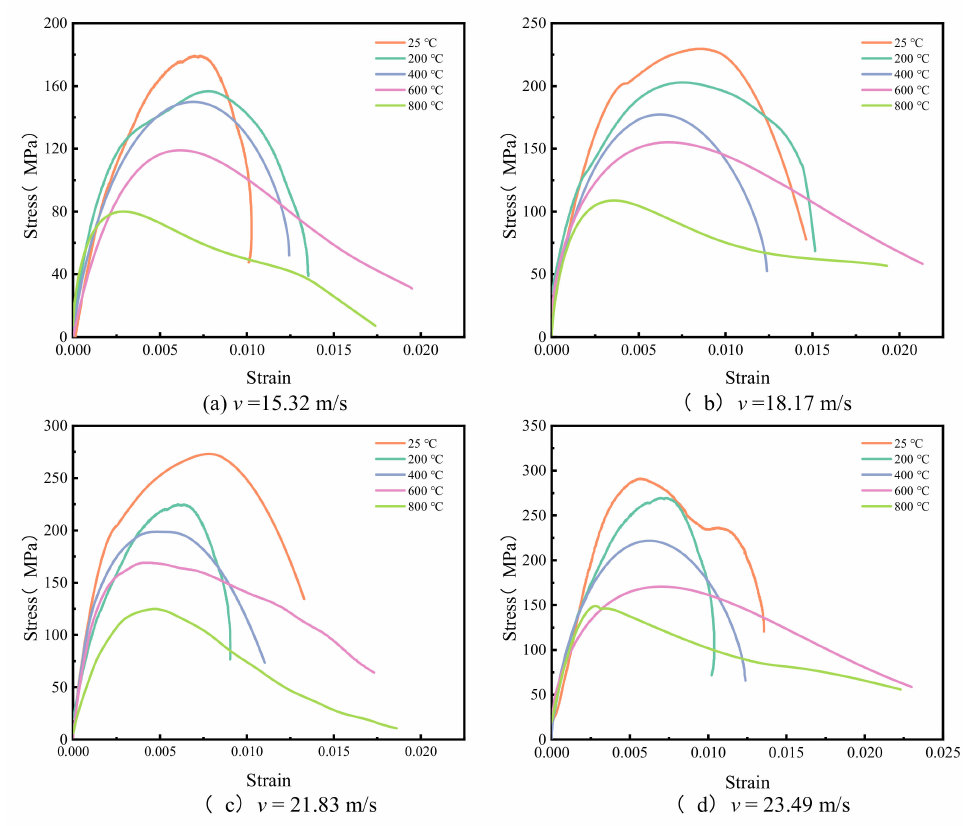
Figure 8. Stress–strain curves in marble after high-temperature treatment.